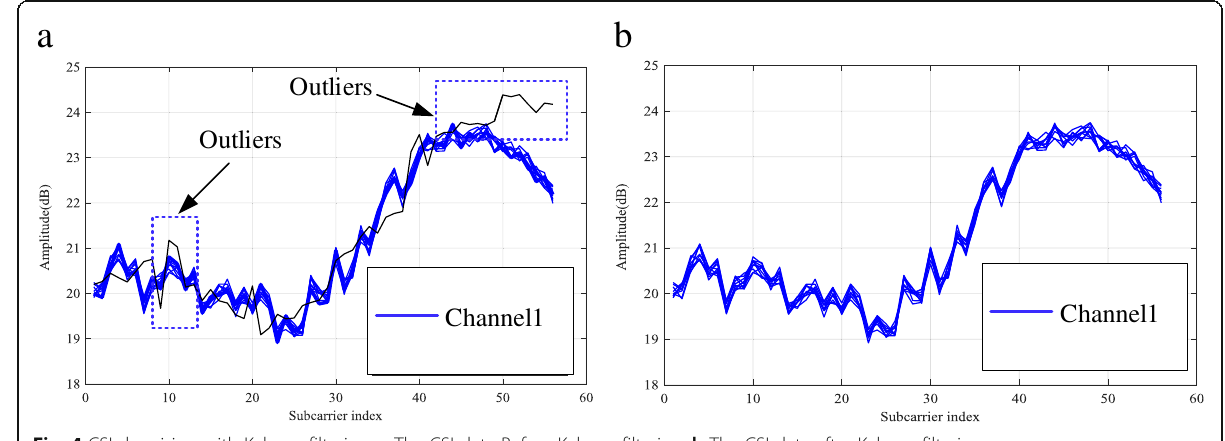
Fig. 4 CSI denoising with Kalman filtering. a The CSI data Before Kalman filtering. b The CSI data after Kalman